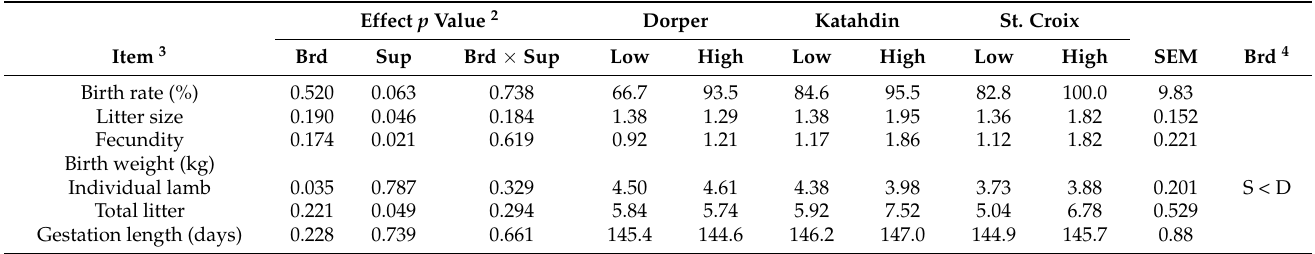
Table 9. Effects of breed and supplement treatment on reproductive performance of hair sheep 1 .